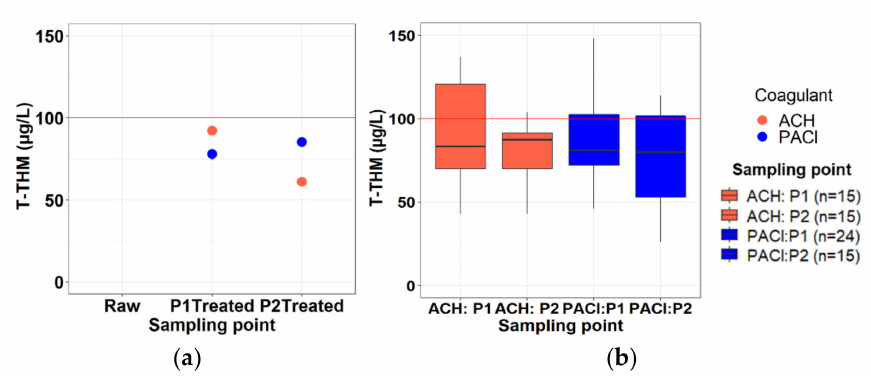
Figure 9. T-THM concentrations: ( a ) N-WTP. ( b ) N-OKP. Note: P1 denotes Phase 1 and P2 denotes Phase 2. The red lines indicate the guideline